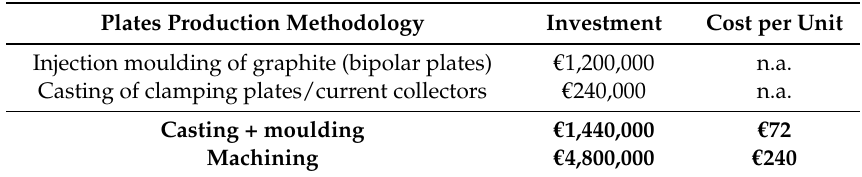
Table 4. Comparison of costs for the production of stack plates with moulding/casting and mechanical